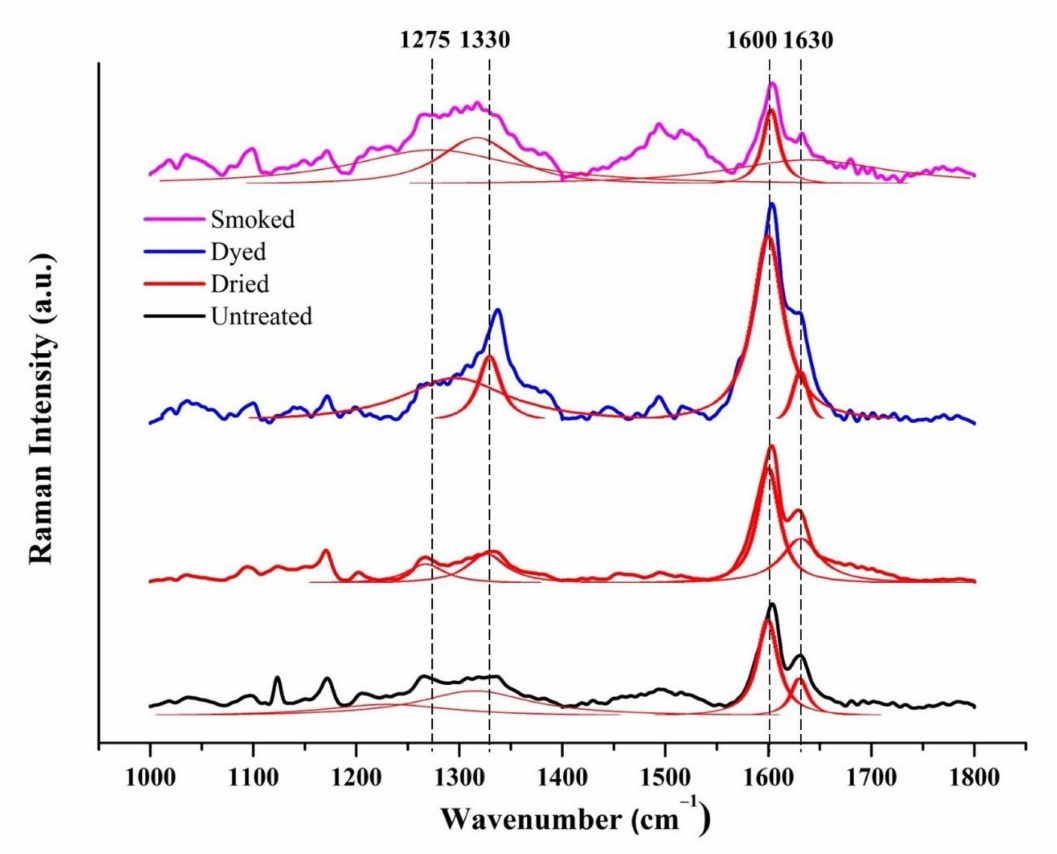
Figure 3. The averaged, normalized, and deconvoluted Raman spectra of untreated and modified bamboo specimens in the spectral range of 1000–1800 cm − 1